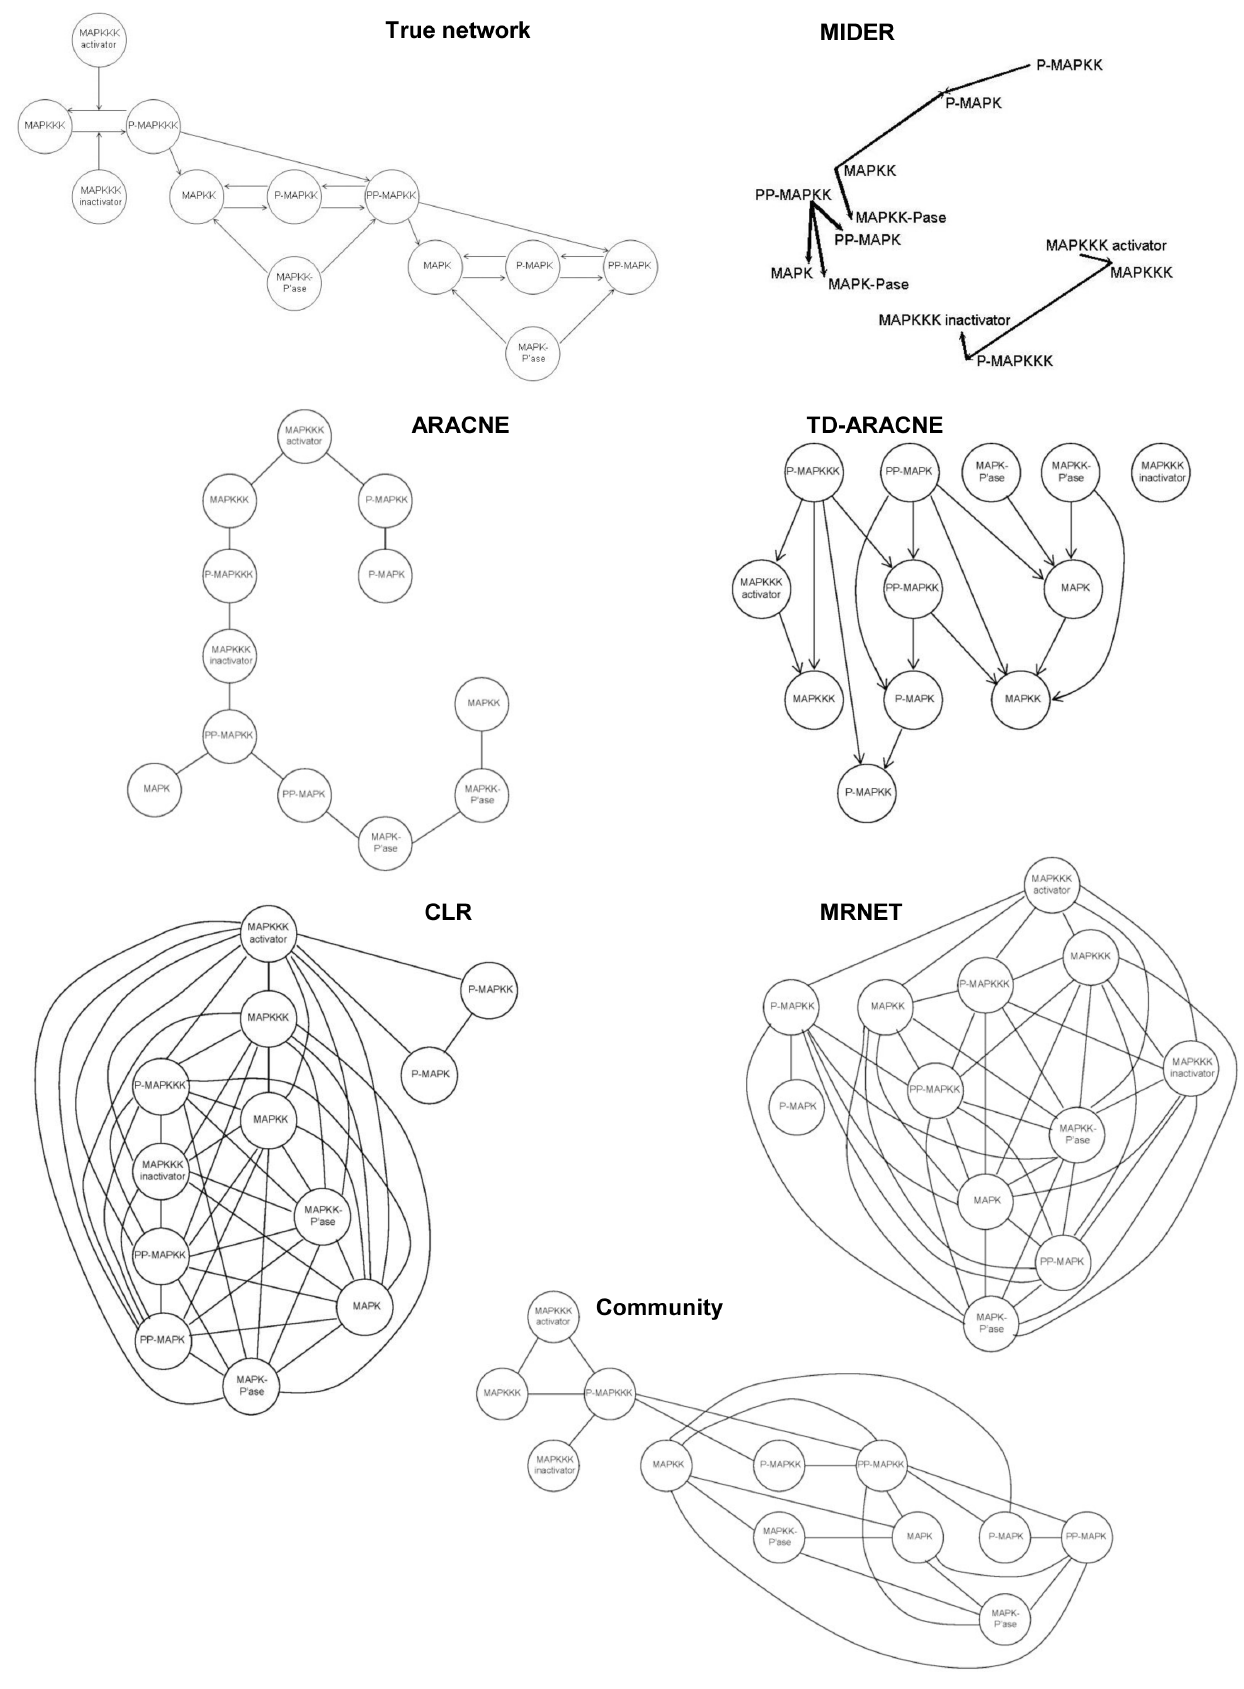
Figure 9. Benchmark B5. MAPK cascade. doi:10.1371/journal.pone.0096732.g009 PLOS ONE |